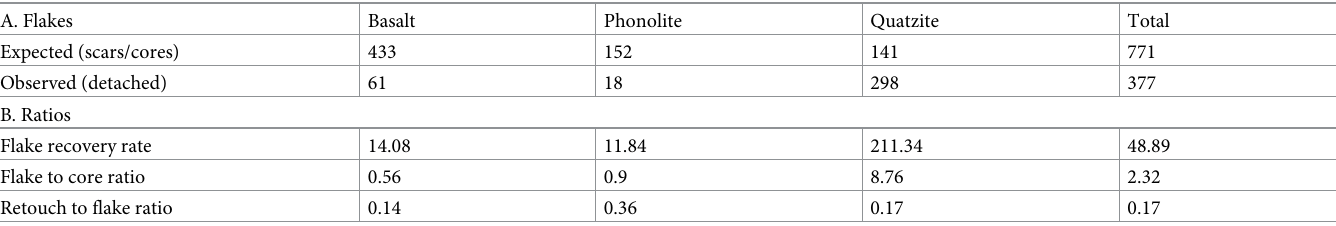
Table 4. Flake ratios in